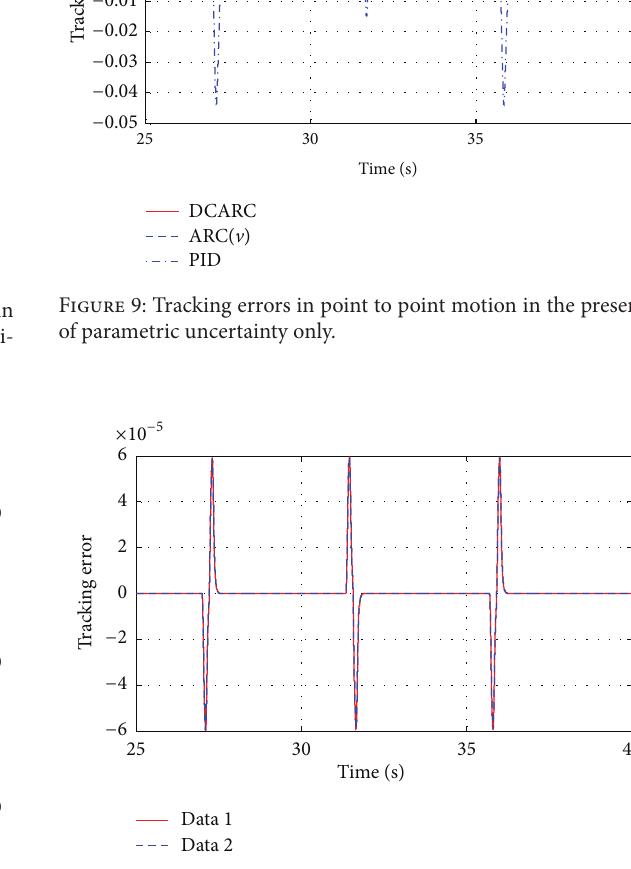
Figure 10: Scaled ARCs’ tracking errors in point to point motion in the presence of parametric uncertainty only.